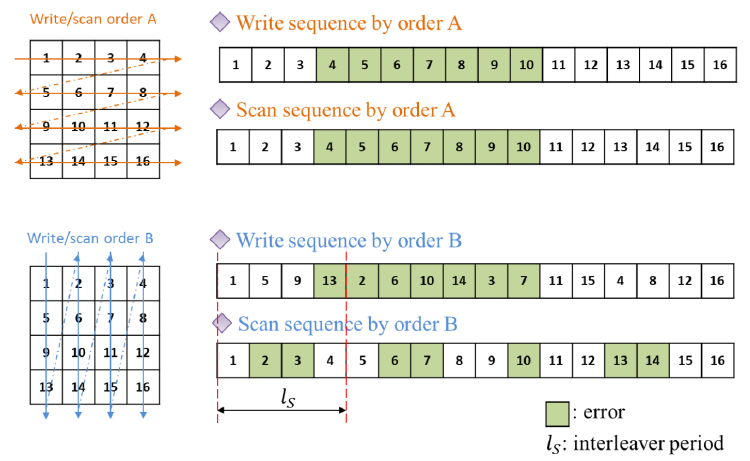
Figure 2. Illustration of block interleavers when the peroid of block interleaver l s = 4.